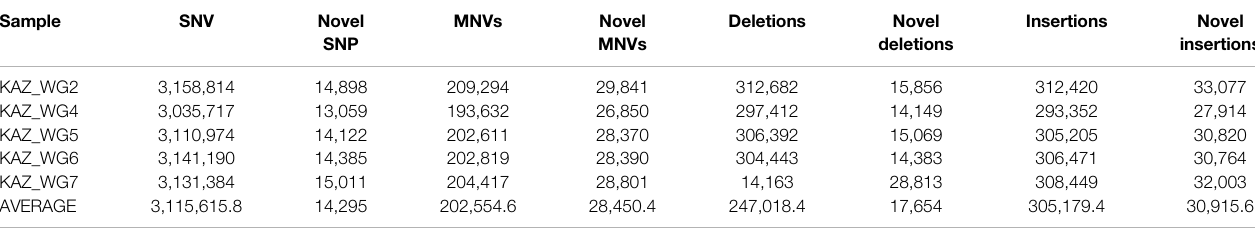
TABLE 2 | Total genetic variants identi fi ed in fi ve Kazakh